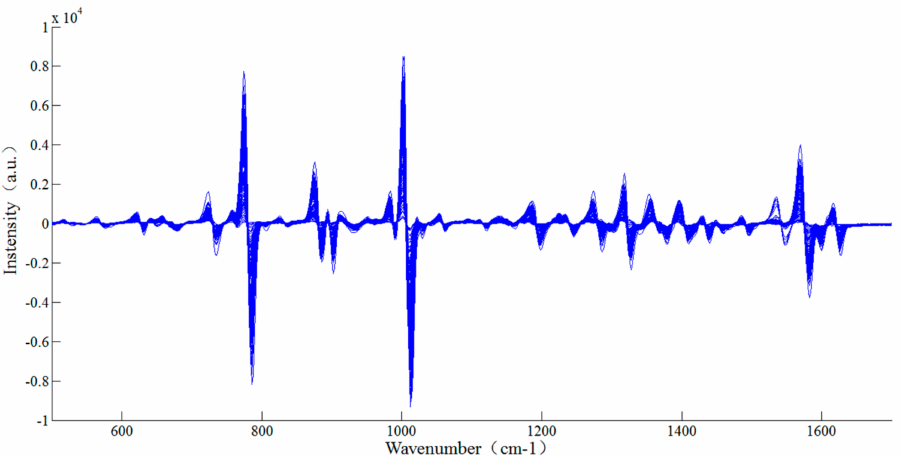
Figure 7. The pretreated spectra after the 1st-Der.